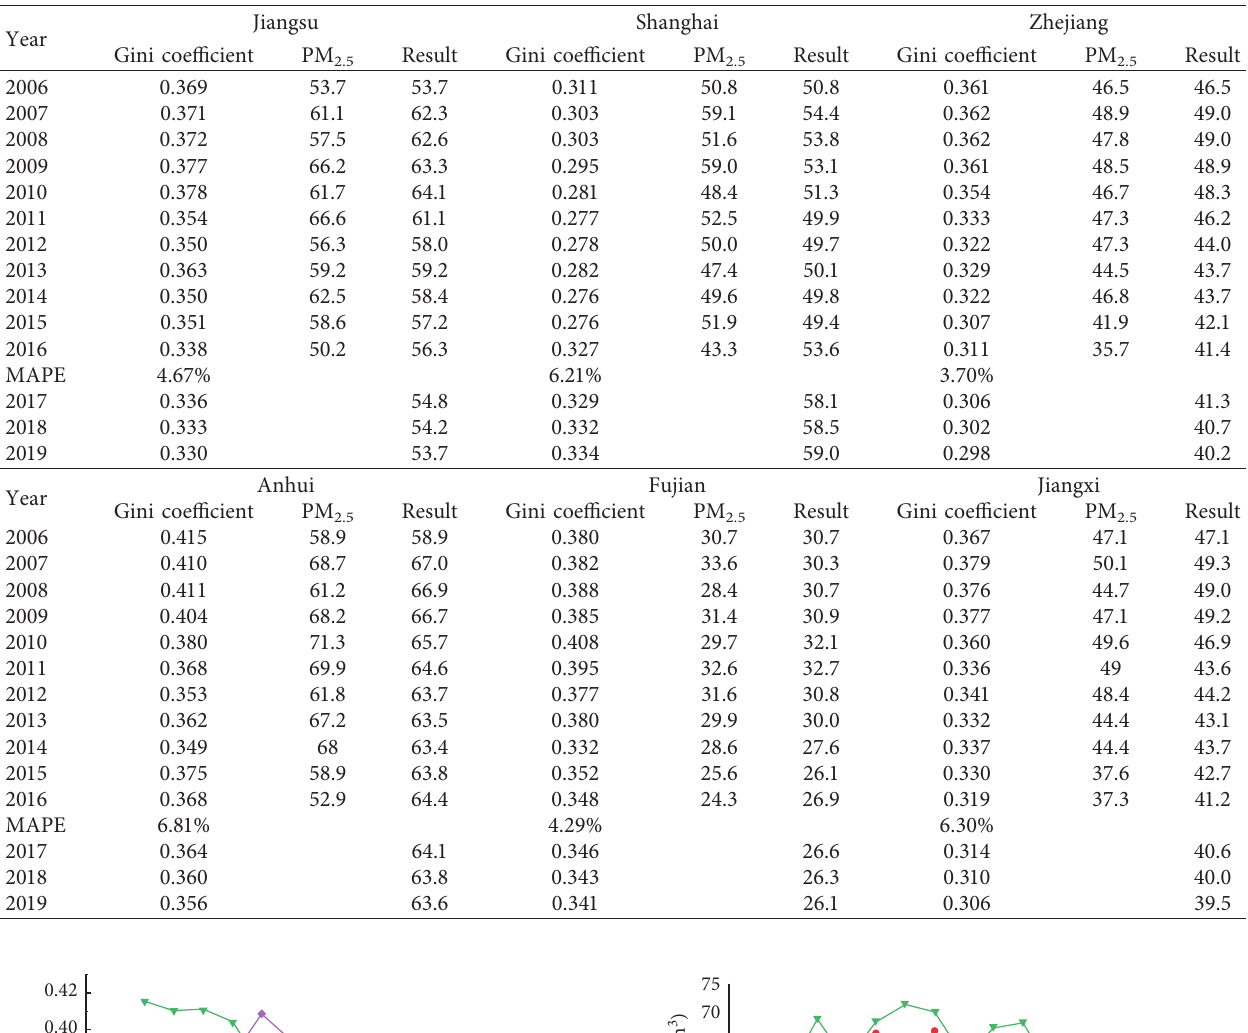
Table 3: Fitting results of the PM